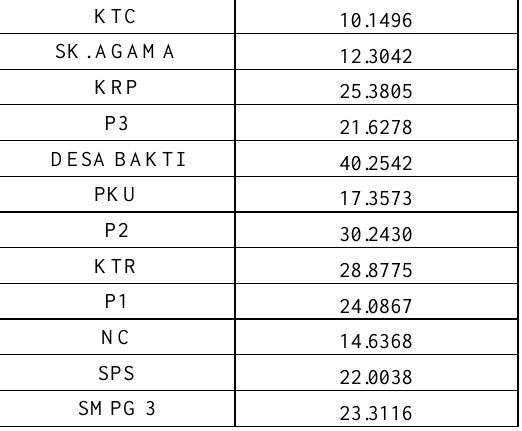
Table 2. MSL heights from precise level for every benchmark point